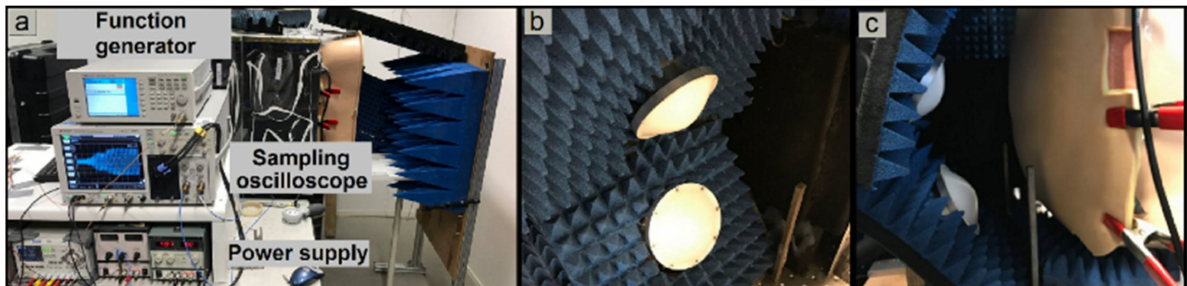
Figure 3. Transient radar method (TRM) set-up used for intra-abdominal pressure (IAP) monitoring. ( a ) TRM set-up in addition to the abdominal wall phantom. In this set-up, the reflection response of the abdominal wall phantom is recorded by means of the sampling oscilloscope. ( b ) Transmitter and receiver antennas in order to radiate electromagnetic waves and receive the reflection signal from the abdominal wall phantom. ( c ) Abdominal wall phantom in front of the transmitter and receiver